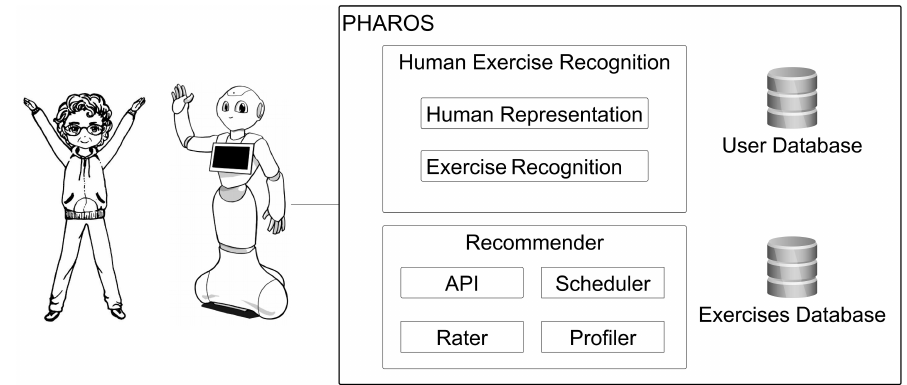
Figure 1. The PHAROS